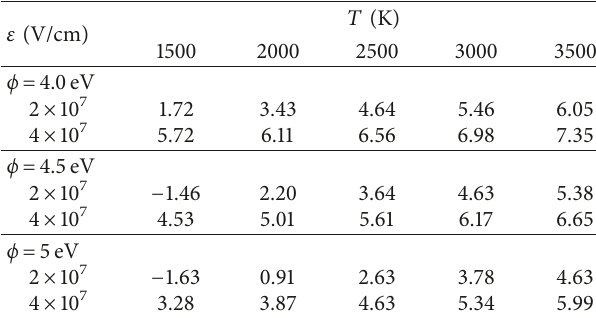
Table 3: Logarithm value of current density under different conditions (lg j )